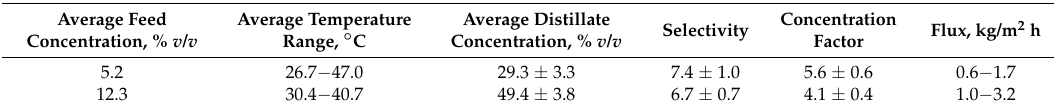
Table 2. Conditions and performance data of the ethanol concentration tests.